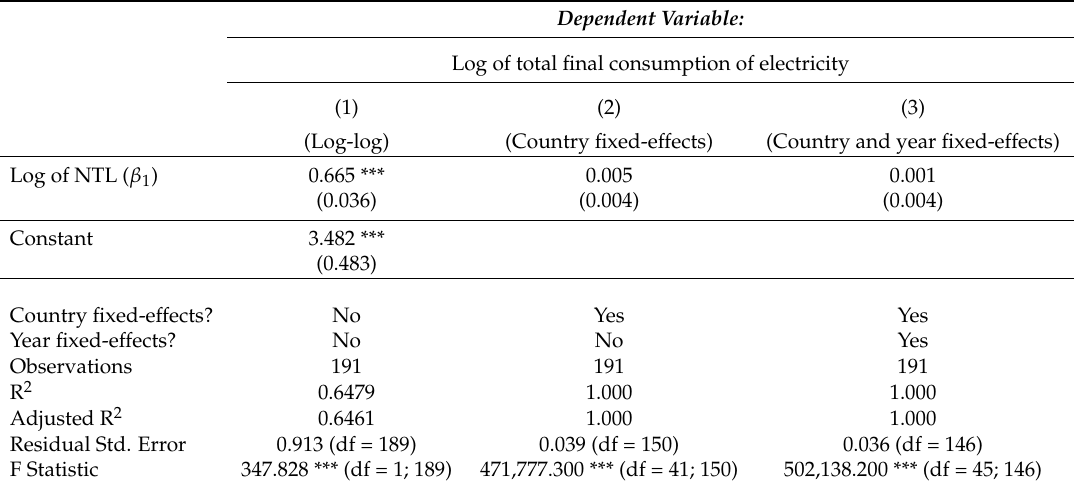
Table 6. High-income countries regression for